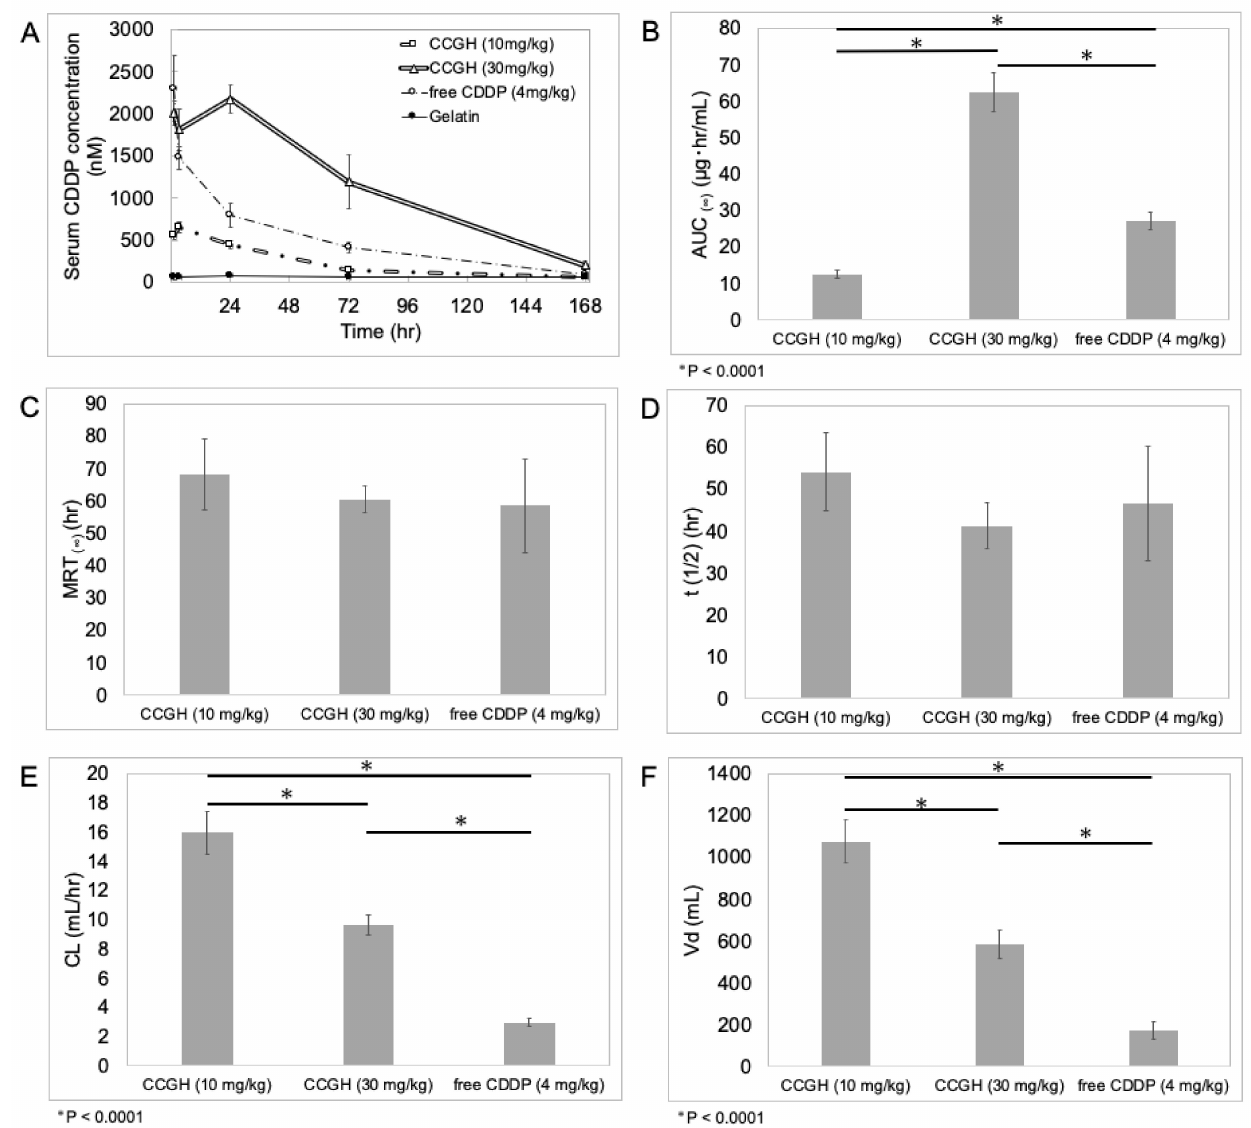
Figure 5. In vivo retention evaluation of CDDP after intraperitoneal administration. ( A ) Serum CDDP concentration profiles after intraperitoneal administration of free CDDP solution, CCGH, and gelatin solution. CCGH (10 mg/kg; double dot-dash line), CCGH (30 mg/kg; double line), free CDDP solution (4 mg/kg; dot-dash line), and gelatin solution (thin solid line). ( n = 5). Data were represented as mean ± SD. ( B – F ) Main pharmacokinetic parameters of CCGH (10, 30 mg/kg) and CDDP (4 mg/kg). ( n = 5). ( B ) AUC, area under the serum concentration–time curve; ( C ) MRT, mean residence time; ( D ) t (1/2), elimination half-life; ( E ) CL, clearance; ( F ) Vd, distribution